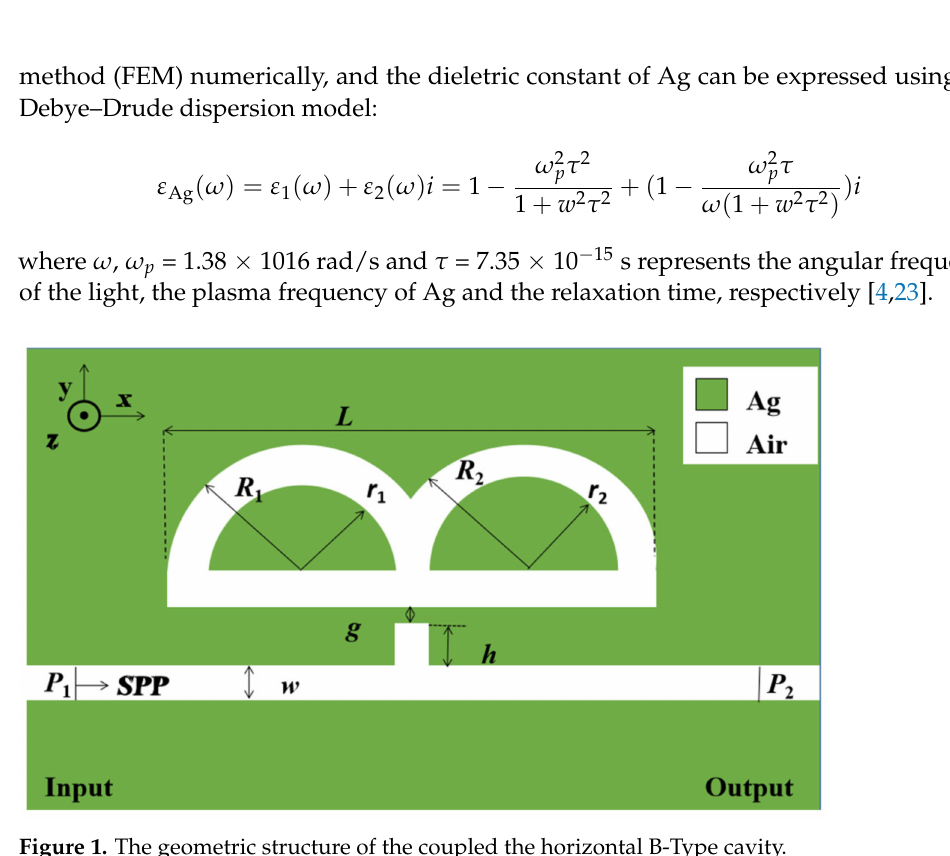
Figure 1. The geometric structure of the coupled the horizontal B-Type